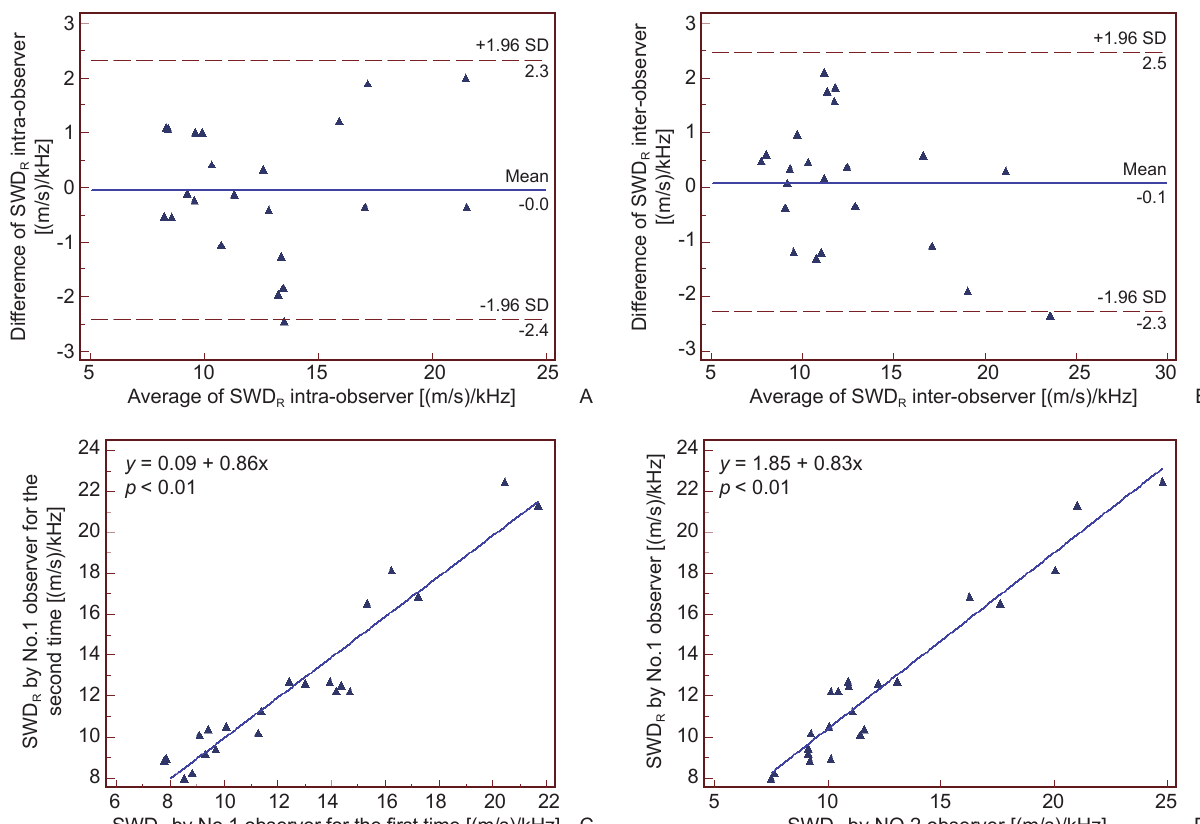
Figure 2 Repeatability test of SWD R by Bland-Altman Plots (A and B) and linear correlation analysis (C and D). Figure 2A. Repeatability test of SWD R intra-observer by Bland-Altman Plots. Figure 2B. Repeatability test of SWD R inter-observer by Bland-Altman Plots. Figure 2C. Repeatability test of SWD R intra-observer by linear correlation analysis. Figure 2D. Repeatability test of SWD R inter-observer by linear correlation